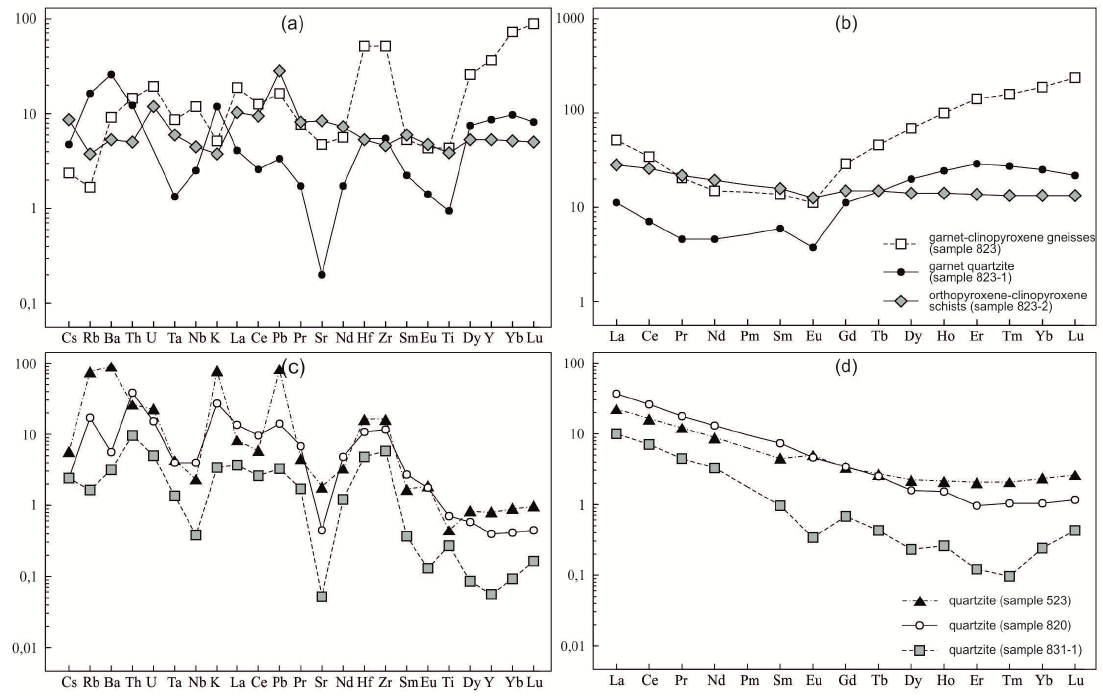
Figure 5. ( a ), ( c ) Primitive mantle-normalized abundances of trace elements; [26] ( b ), ( d ) Figure 5. ( a , c ) Primitive mantle-normalized abundances of trace elements; [26] ( b , d ) chondrite- chondrite-normalized [26] REE patterns for zircons. normalized [26] REE patterns for